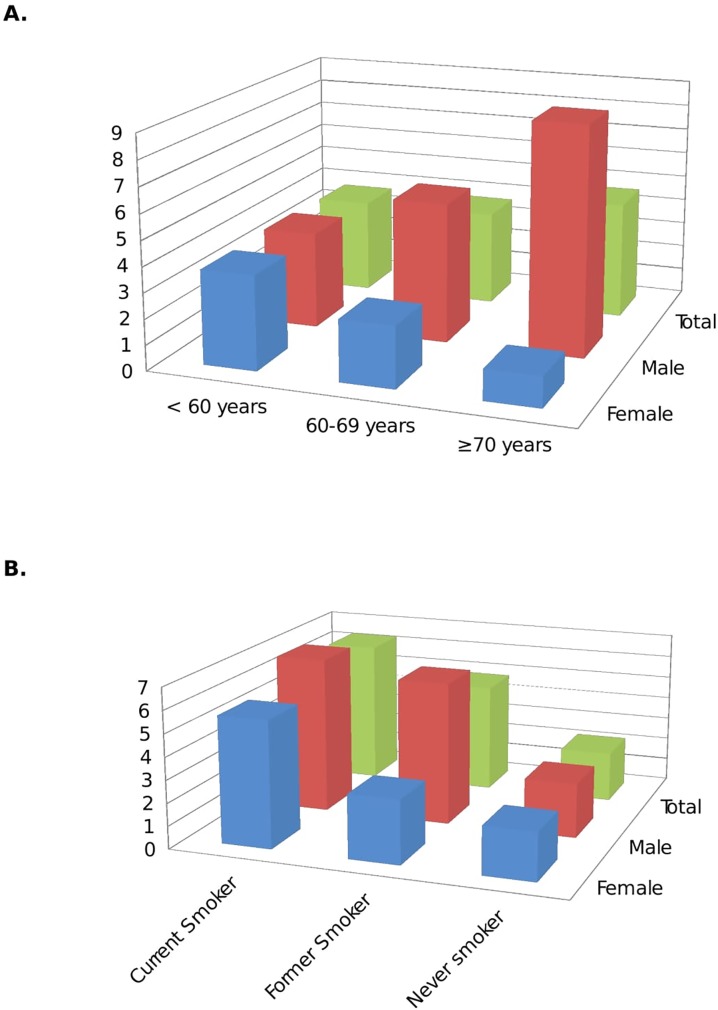
Prevalence of PAD stratified by age group and gender (A) and by smoking status and gender (B).